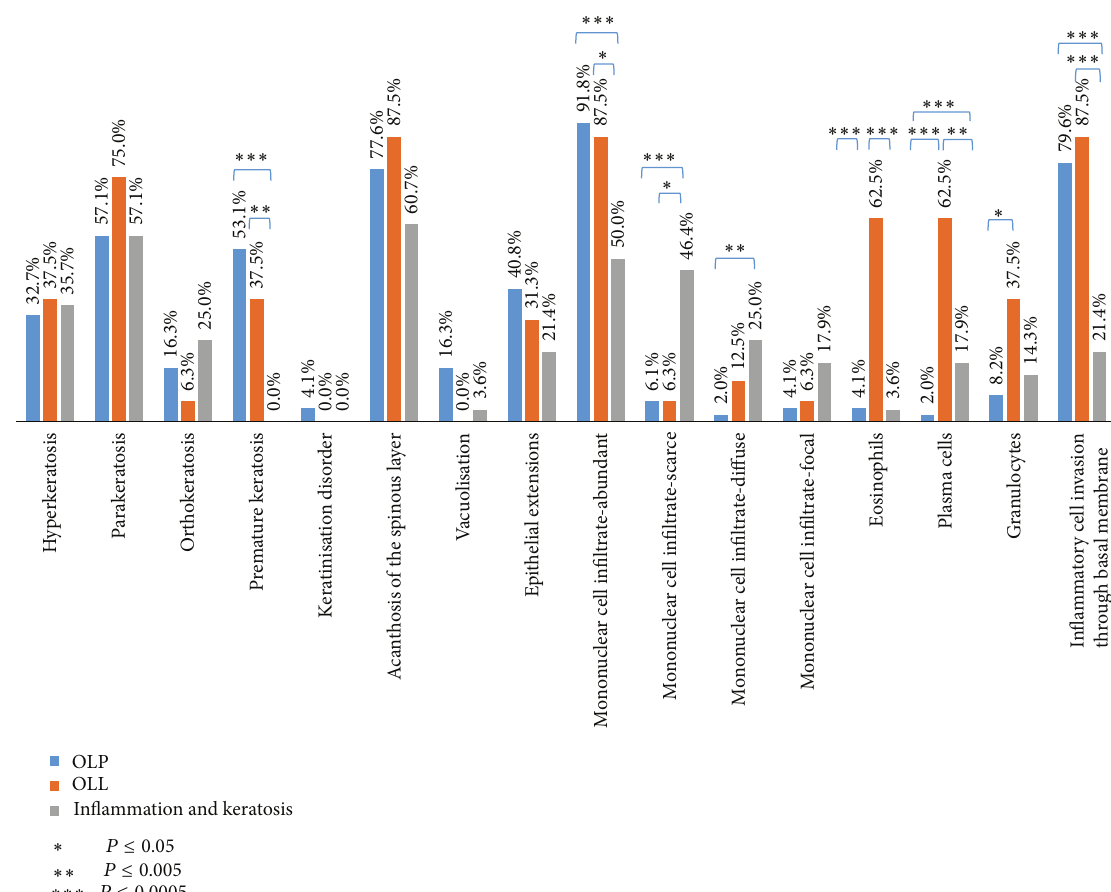
Figure 2: The distribution of histopathologic criteria between the diagnosis oral lichen planus (OLP) and oral lichenoid lesion (OLL).